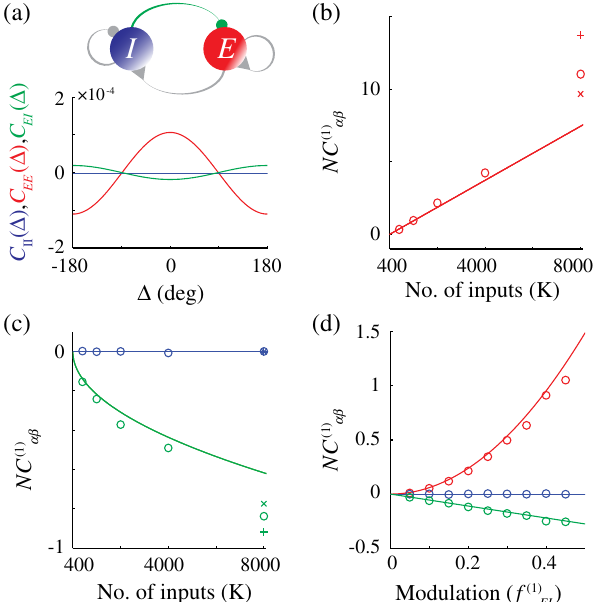
FIG. 3. Correlations in a two-population network with an explicit feed-forward structure. Connection probabilities as in 1 Þ 1 Þ 1 Þ Eq. (29). Parameters: f ð ¼ f ð ¼ f ð ¼ 0 . Panels (a) – (c): EE IE II 1 Þ f ð ¼ 0 . 25 . Interaction strengths as in Fig. 2. (a) Top panel: EI The network architecture. Green: The connections which are 1 Þ ≠ 0 ). Connections in gray are unstruc- spatially modulated ( f ð EI 1 Þ 0 ). Bottom panel: Simulation results for C Δ Þ ; tured ( f ð αβ ð αβ ¼ 1 Þ N ¼ 40 000 , K ¼ 2000 . (b),(c) NC ð αβ vs K . Solid lines: Ana- lytical results, Eq. (31). Simulation results are plotted for N ¼ 20 000 (plus), N ¼ 40 000 (circles), and N ¼ 80 000 (crosses). 1 Þ 1 Þ 1 Þ 1 Þ ð 1 Þ (b) NC ð . (c) Blue, NC ð . Green, NC ð . (d) NC ð . Solid αβ vs f EE II EI EI lines: Analytical results, Eq. (31); N ¼ 40 000 , K ¼ 400 .